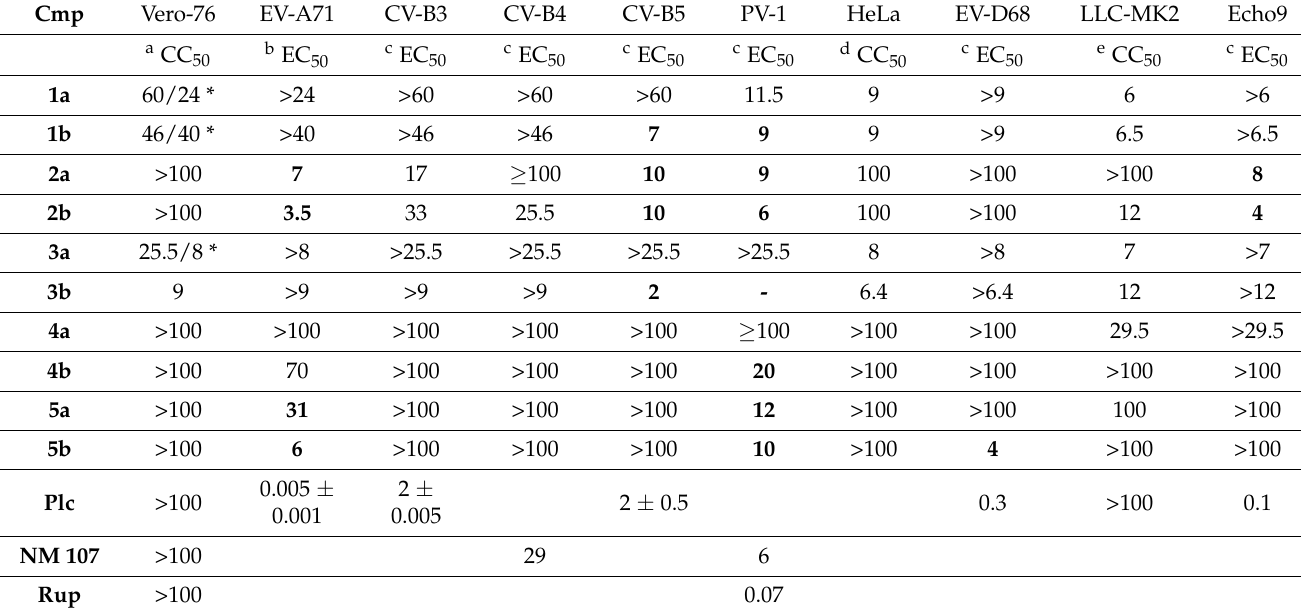
Table 1. Cytotoxicity and antiviral activity of benzimidazole (BIZ) derivatives and references against representatives of Enterovirus (EV-A71, CV-B3, CV-B4, CV-B5, PV-1, EV-D68, and